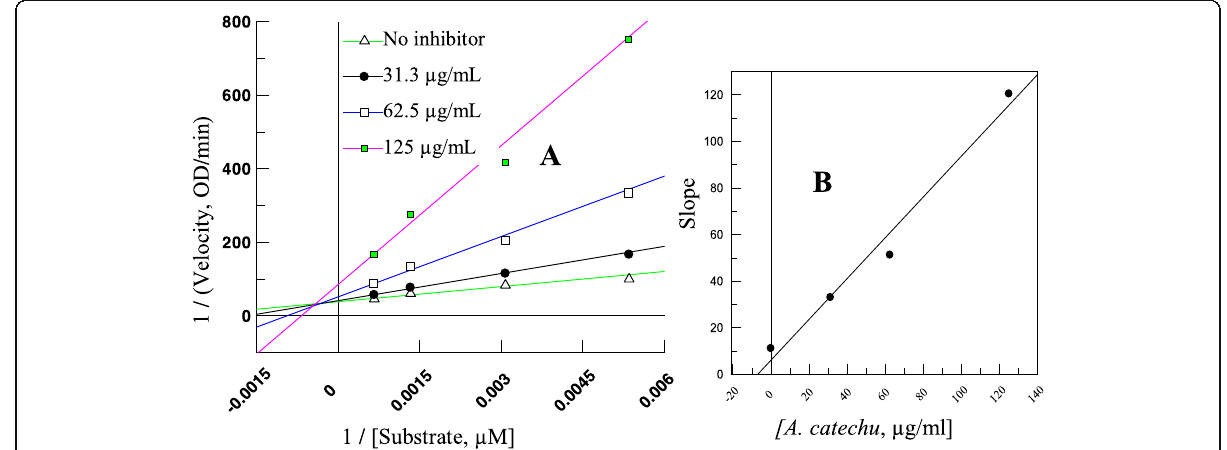
Fig. 1 α -Amylase inhibition kinetics study. a Line-weaver Burk plot of extracts of A. catechu . b The secondary plot of Line-weaver Burk